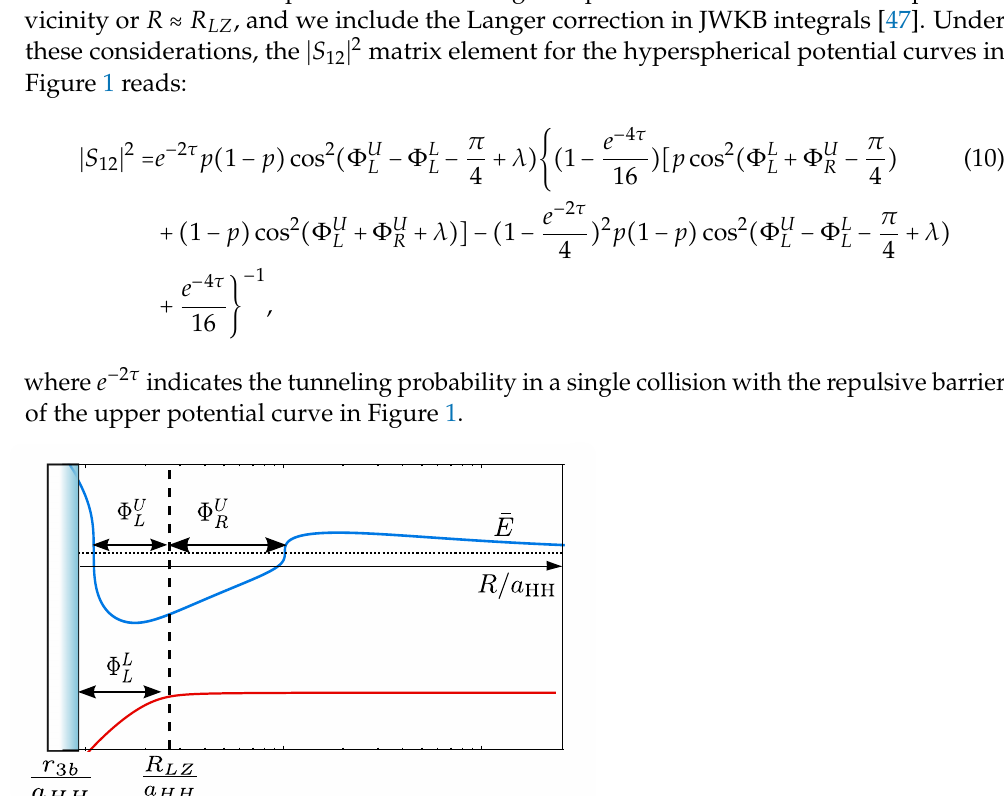
Figure 1. An illustration of the lowest hyperspherical potential curves U 1 and a HL < 0. The red (blue) line saturates at large hyperradii in the atom–dimer (three-body break-up) threshold. The quantities Φ U L and Φ U L indicate the JWKB phase accumulation in the upper potential curve. For the lower potential, the corresponding phase is denoted by Φ L L . The vertical dashed line represents the hyperradius where the non-adiabatic coupling P -matrix element P 12 maximizes. The horizontal dotted line refers to the three-body collisional energy ¯ E in units of ¯ h three-body parameter, r 3 b , depicted by the blue a HH